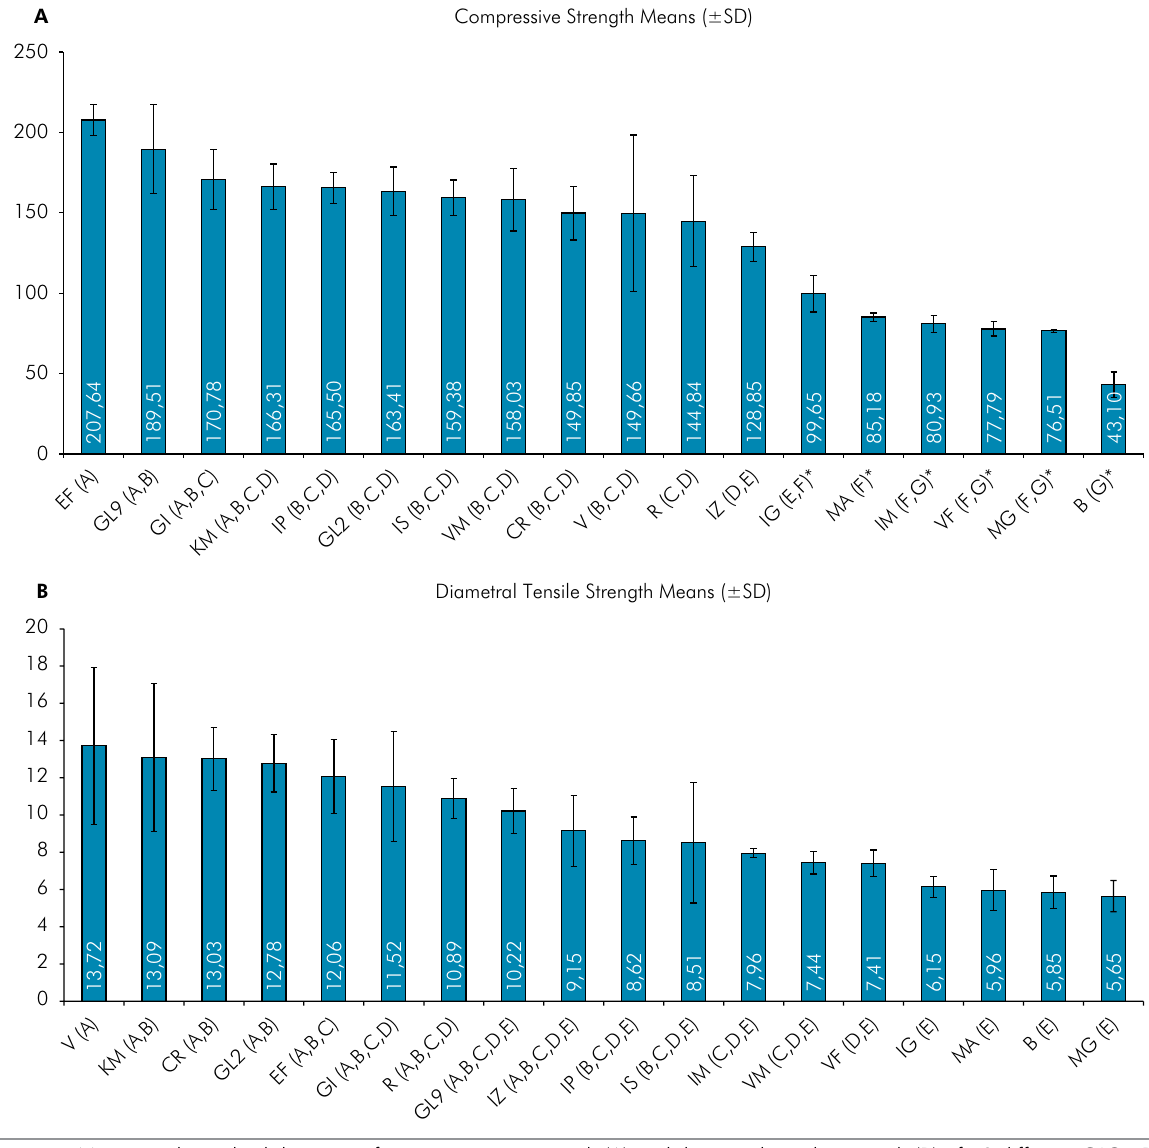
Figure 1. Means and standard deviations for compressive strength (A) and diametral tensile strength (B) of 18 different GICs. Bars with the same letters under them present no statistical difference (p>0.05). Results marked with a (*) did not achieve the minimum cut off point that was established by